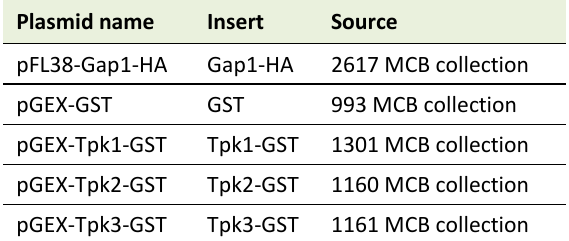
TABLE 2. Plasmids used in this